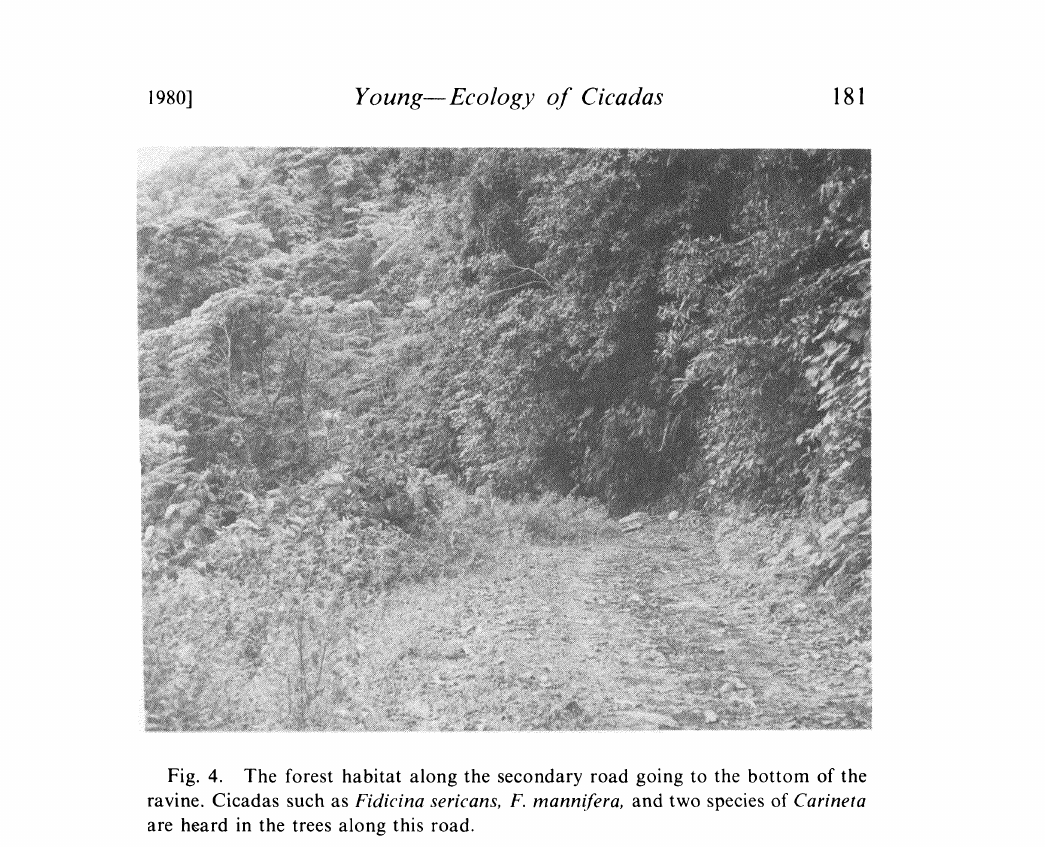
Fig. 4. The forest habitat along the secondary road going to the bottom of the ravine. Cicadas such as Fidicina sericans, F. mann!fera, and two species of Carineta are heard in the trees along this